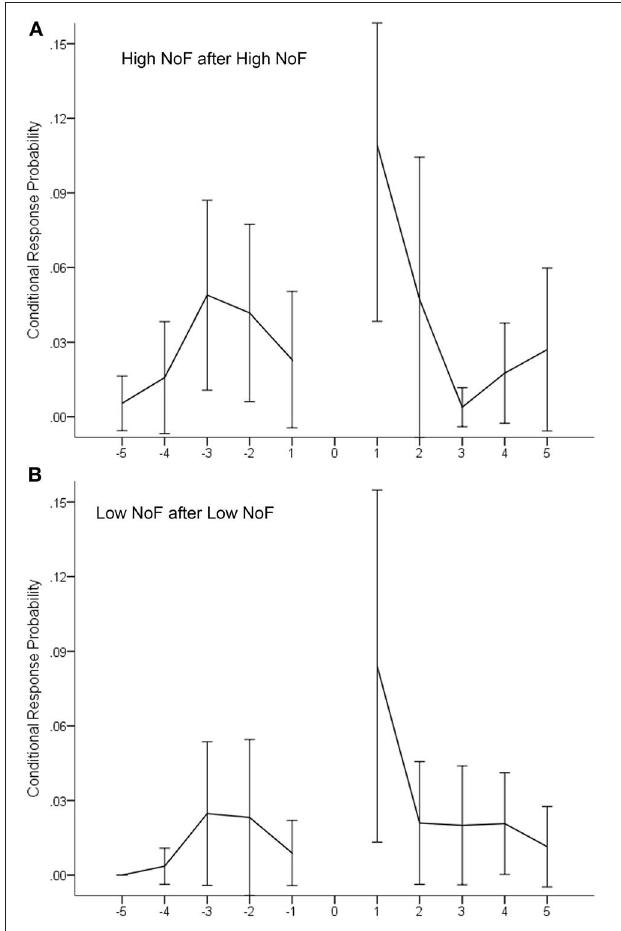
FIGURE 2 | Mean conditional probability plotted against distance from last item recalled for (A) High|High NoF and (B) Low|Low NoF items. in favor of recalling items from study list positions that are nearer to the